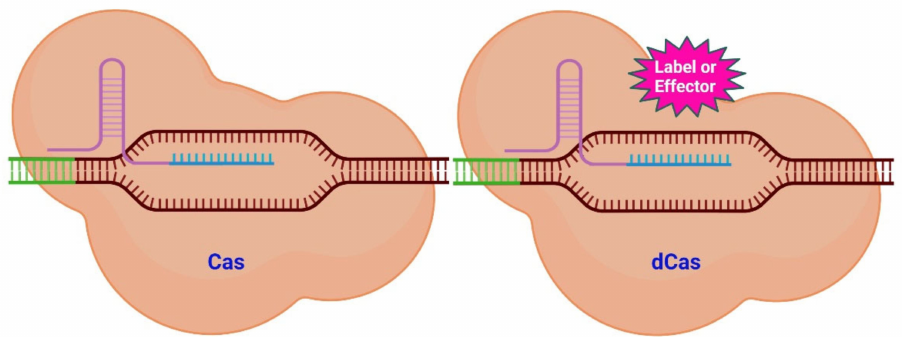
Figure 1. Scheme of CRISPR/Cas system variants. Targeting a specific genomic region (brown) with its sgRNA (lilac and turquois) is the function of the Cas system ( left ). The Cas protein will subsequently cut into the neighboring DNA region (green). The dCas system ( right ) uses a similar mechanism to that of the CAS system to target a genomic region. The dCas protein, however, lacks endonuclease activity. Numerous compounds may be fused to the dCas protein (pink) (labels and effectors). Labels place a fluorescent signal near to the target DNA, while effectors are able to alter the epigenetic state of the DNA. Modified from [37] and generated with BioRender